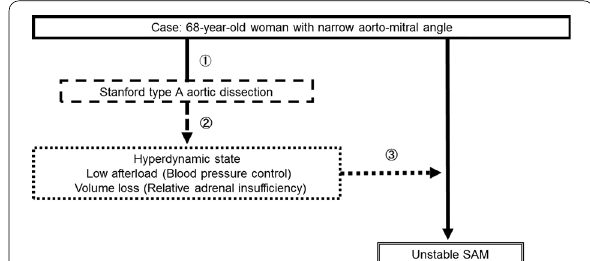
Fig. 6 Possible mechanism of systolic anterior motion of the mitral valve associated with acute type A aortic dissection. 1 A 68-year-old woman with narrow aorto-mitral angle had acute type A aortic dissection. 2 Blood pressure control leading to low afterload was needed for prevention of recurrent aortic events, and physical stress due to aortic dissection caused relative adrenal insufficiency, leading to volume loss. 3 Unstable SAM of the patient with narrow aorto-mitral angle became apparent due to hyperdynamic state after aortic dissection, low afterload, and volume loss. SAM systolic anterior motion of mitral